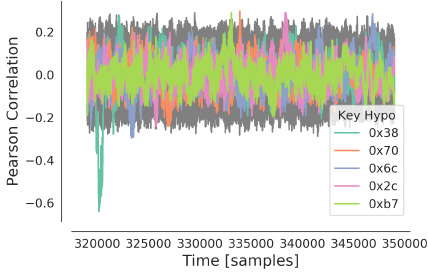
Figure 29: Pearson Correlation coefficients in Step 3 (byte 0) with 256 traces.